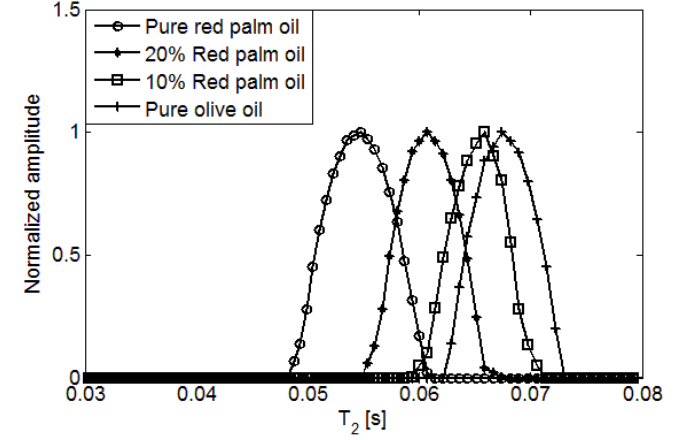
Figure 7. 1d T distribution of red palm and extra virgin olive mixed 2